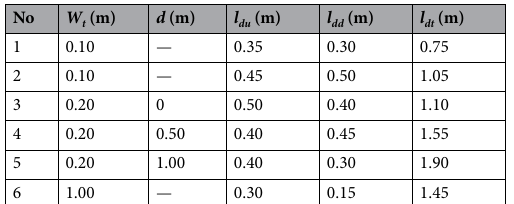
Table 5. Measured results of the deposition range for each test. Note: W t = total width of TFPW; d = distance between the Double TFPW; l du = deposition length upstream of TFPW; l dd = deposition length downstream of TFPW; l dt = total length of